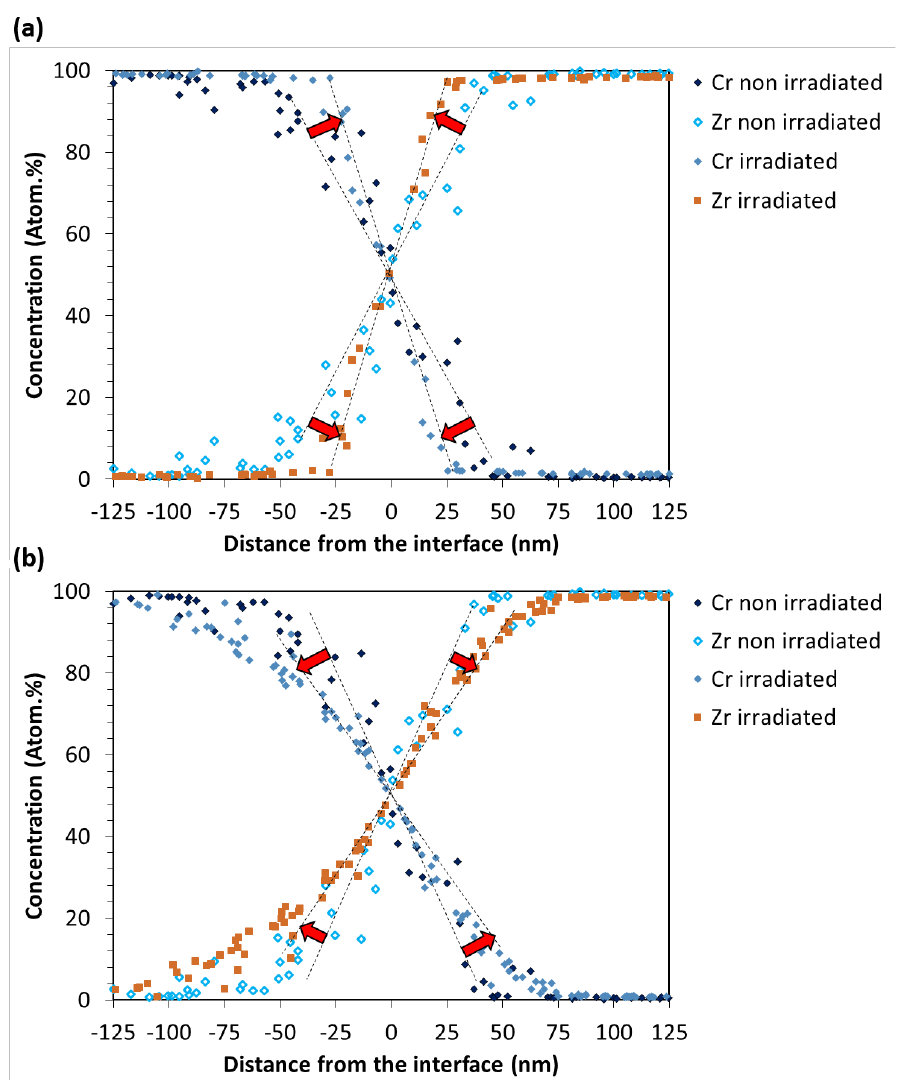
Figure 6. Concentration profile of Zr and Cr atoms across the interface: ( a ) before and after in situ irradiation (interface sharpening), ( b ) before and after ex situ irradiation (interface broadening).